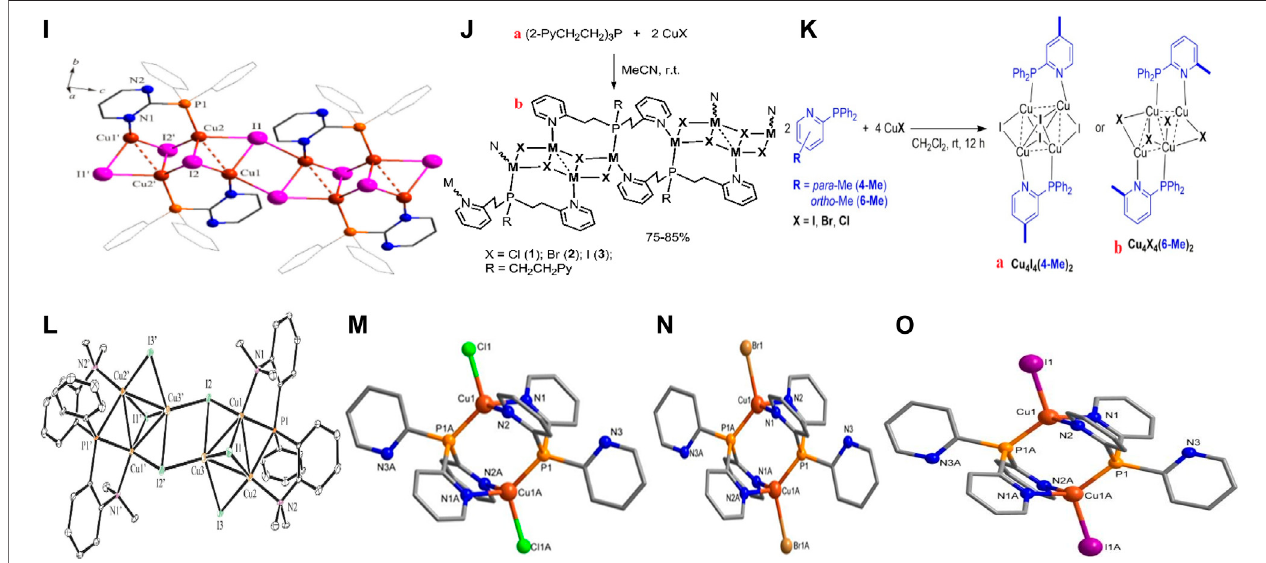
FIGURE 2 | The crystal structures of complexes